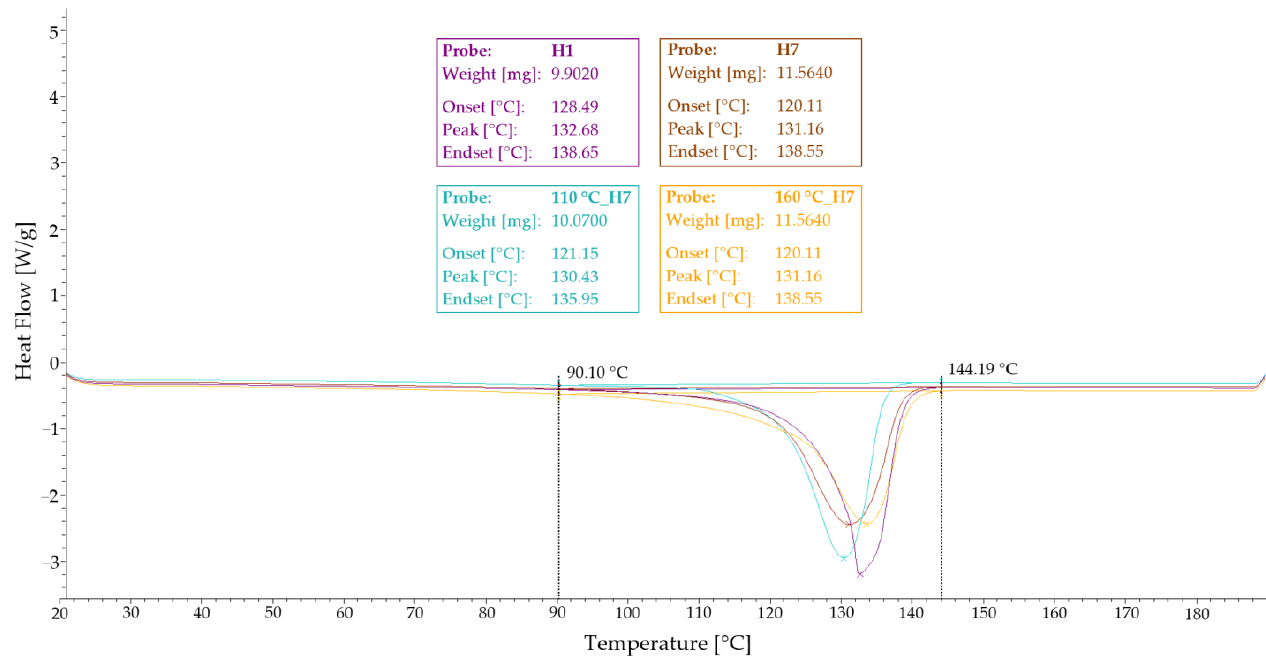
Figure 10. DSC measurement — 1st heating of selected specimens from each group.